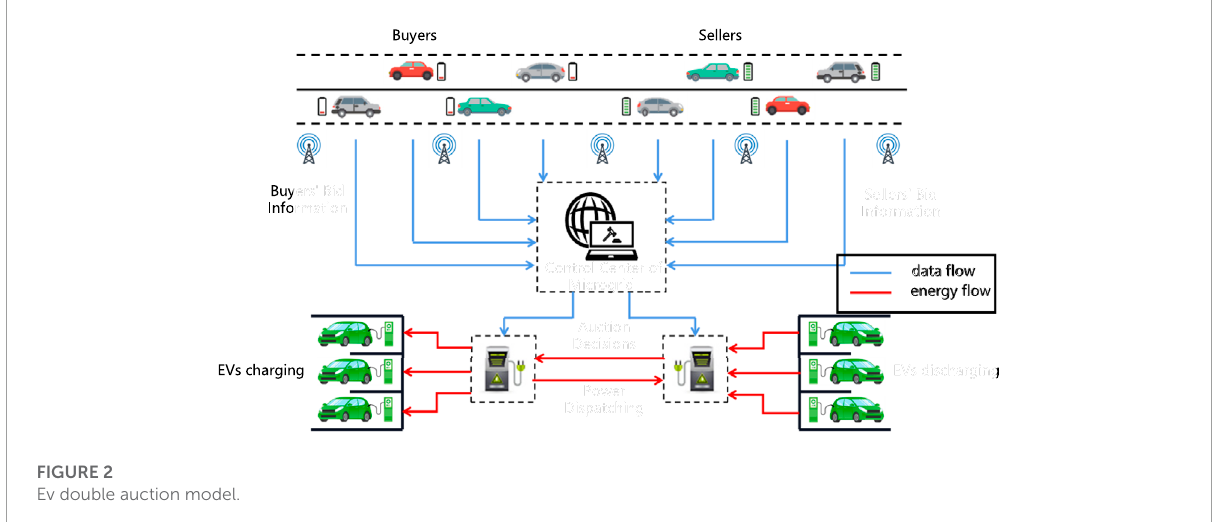
FIGURE 2 Ev double auction